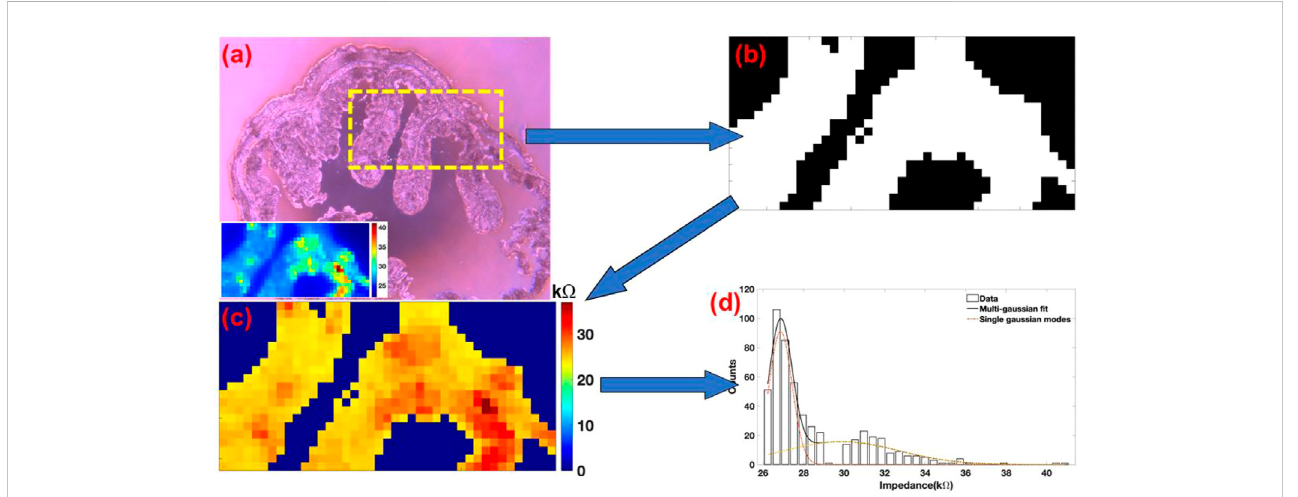
FIGURE 3 (A) Bright fi eld image of the colon section. A dotted yellow rectangle marks the region of the scan. Bottom left a representative impedance map of the image. (B) Binary image of the colon section used as an overlay for masking the glass substrate. (C) Masked image of the colon section. Data from the